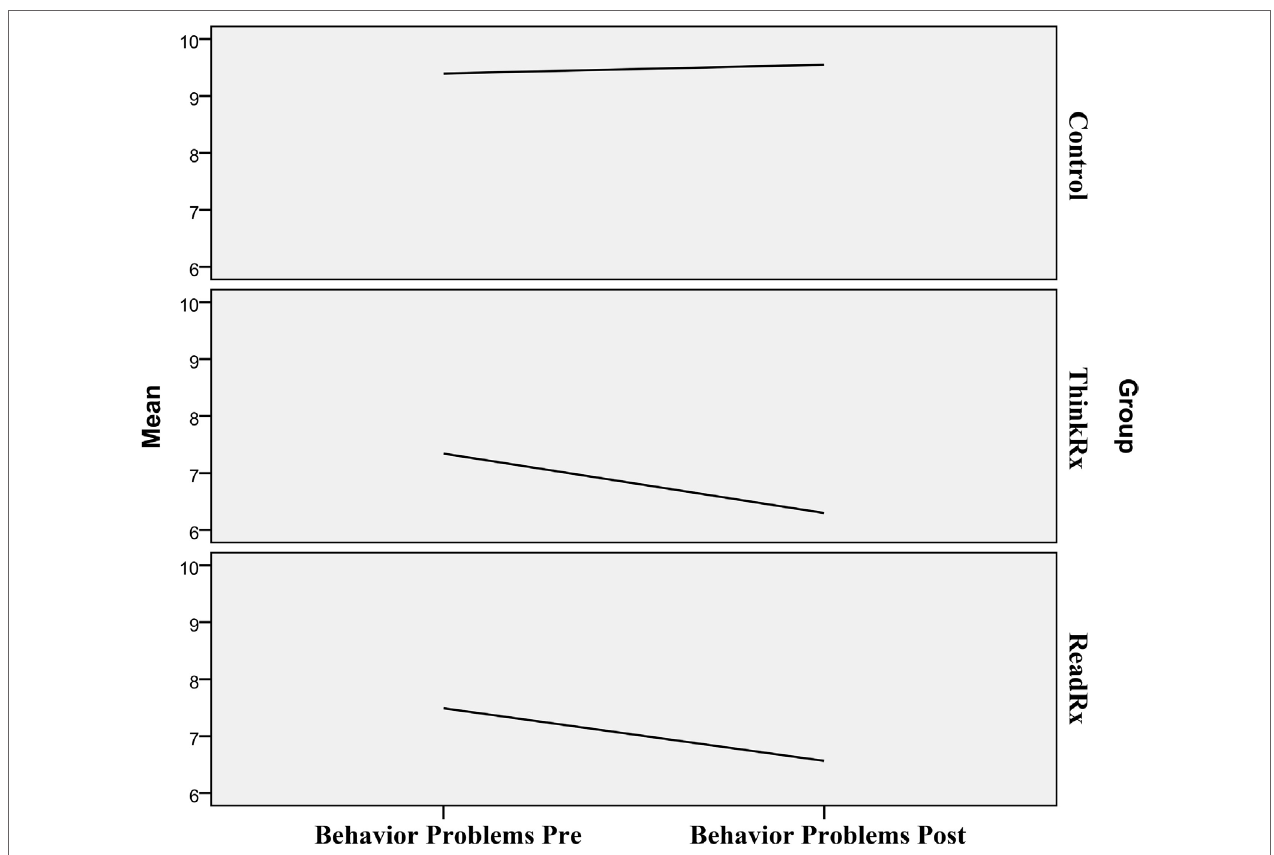
FigUre 3 | Changes in parent ratings of oppositional